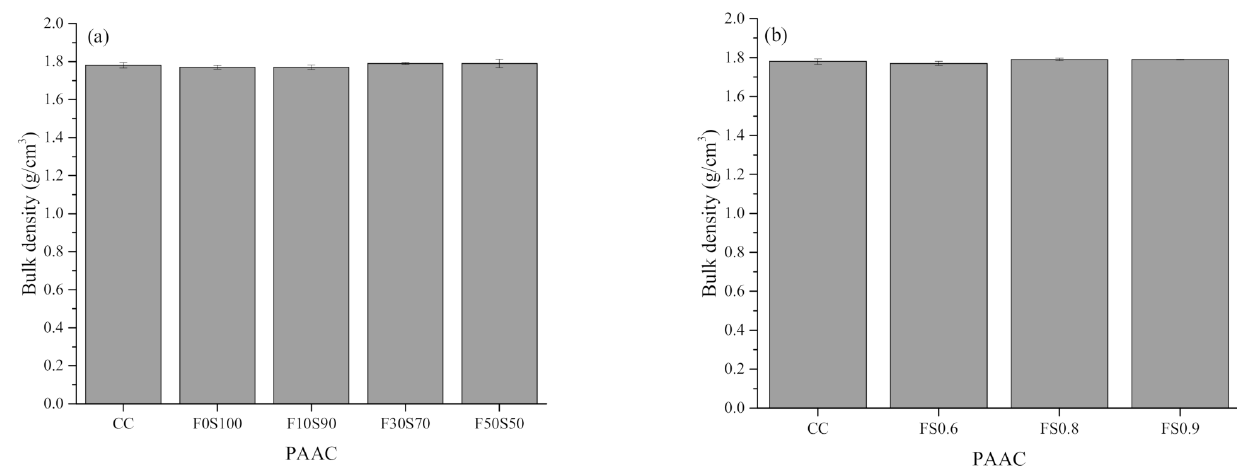
Figure 7. Bulk density of preplaced aggregate concrete mixes: ( a ) Series 1 and ( b ) series 2.